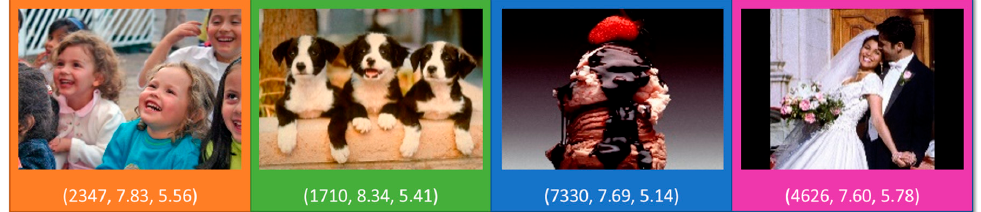
Figure 2. Examples of the pictures used in this study. The three numbers in the brackets indicate the IAPS identification (ID), mean valence rating, and mean arousal rating of each picture.